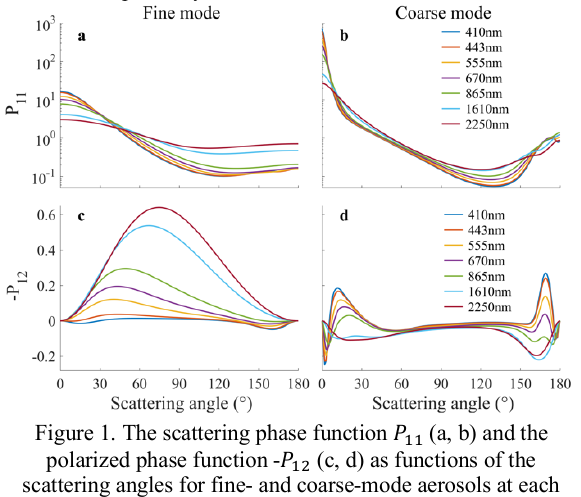
(a, b) and the Figure 1. The scattering phase function 𝑃 ** (c, d) as functions of the polarized phase function - 𝑃 *+ scattering angles for fine- and coarse-mode aerosols at each wavelength adopted for the information content analysis